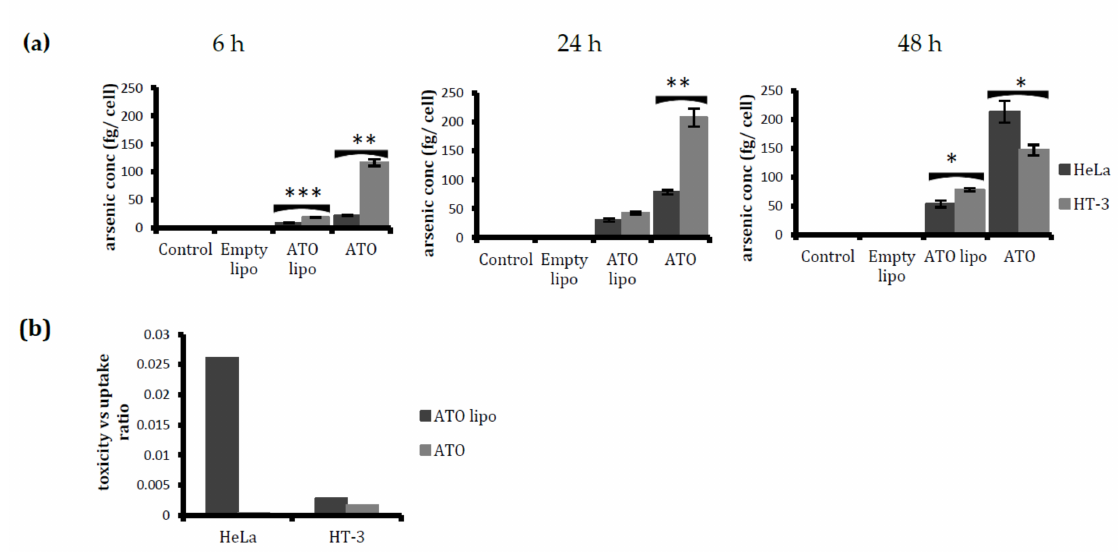
Figure 5. A comparative study of the arsenic uptake and toxic response of different drug formulations on HeLa and HT-3 cells. ( a ) Comparison of the arsenic uptake by HeLa and HT-3 after 6, 24, and 48 h of treatment—as determined by inductively coupled plasma mass spectrometry (ICP-MS). Free ATO was taken up more than ATO lipo in both cell lines. However, the uptake was higher in HT-3 for all treatments, except for the free ATO uptake after 48 h. ( b ) Ratios of toxicity vs. uptake of liposomal and free ATO for the two cervical cancer cell lines after 24 h treatment. Data are displayed as mean ± SD from at least three independent experiments; * p < 0.05, ** p < 0.01, and *** p <